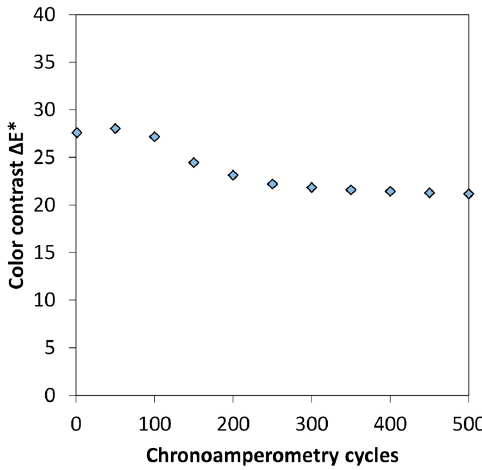
Figure 5. Color contrast ∆ E* as a function of the number of chronoamperometry cycles, measured on an electrochromic symmetrical display built from 880 nm PEDOT:PSS thick film.